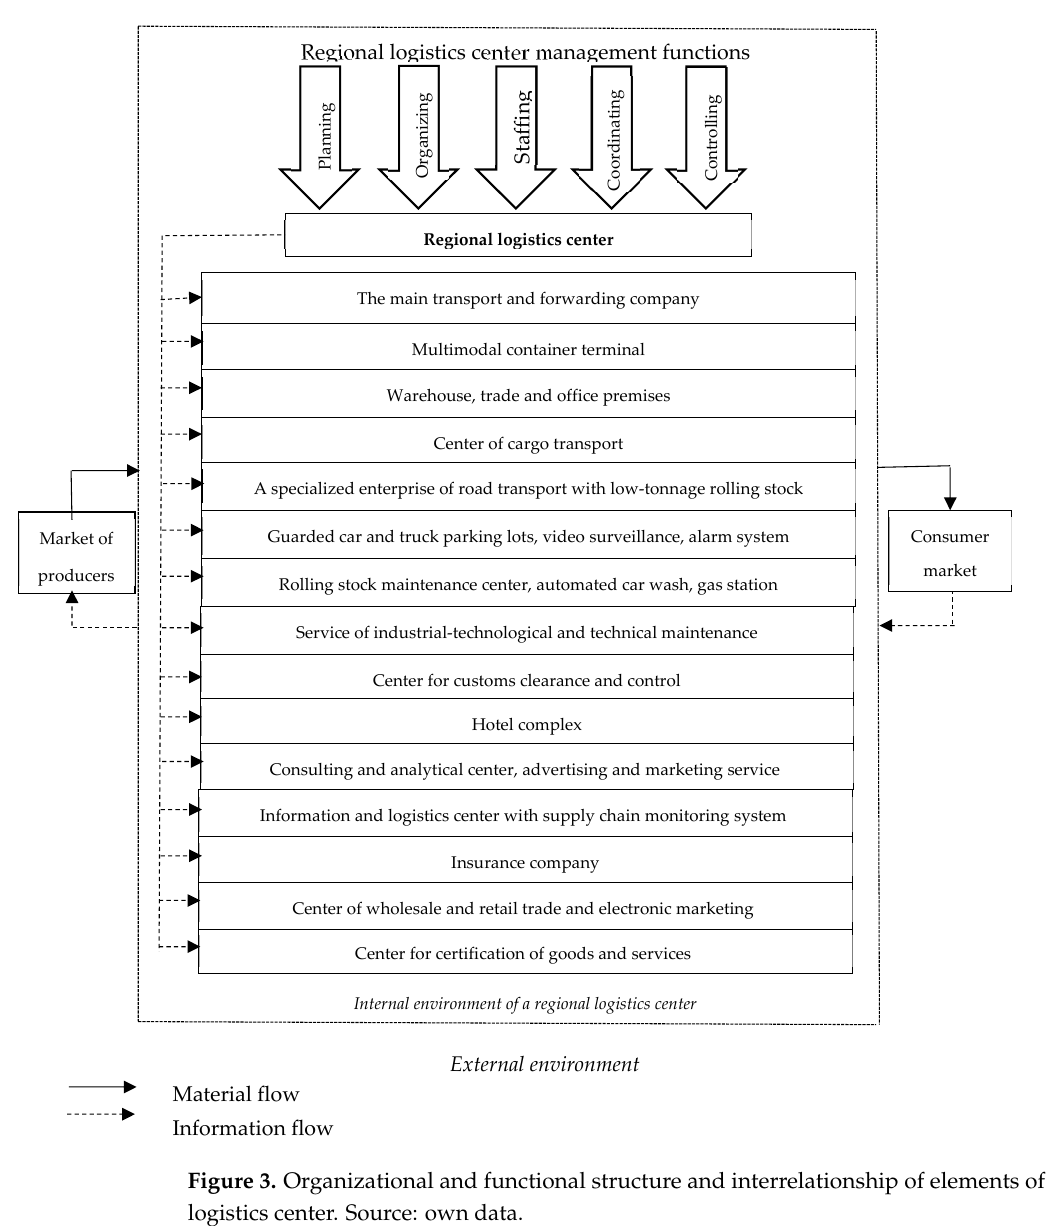
Figure 3. Organizational and functional structure and interrelationship of elements of the regional logistics center. Source: own data.